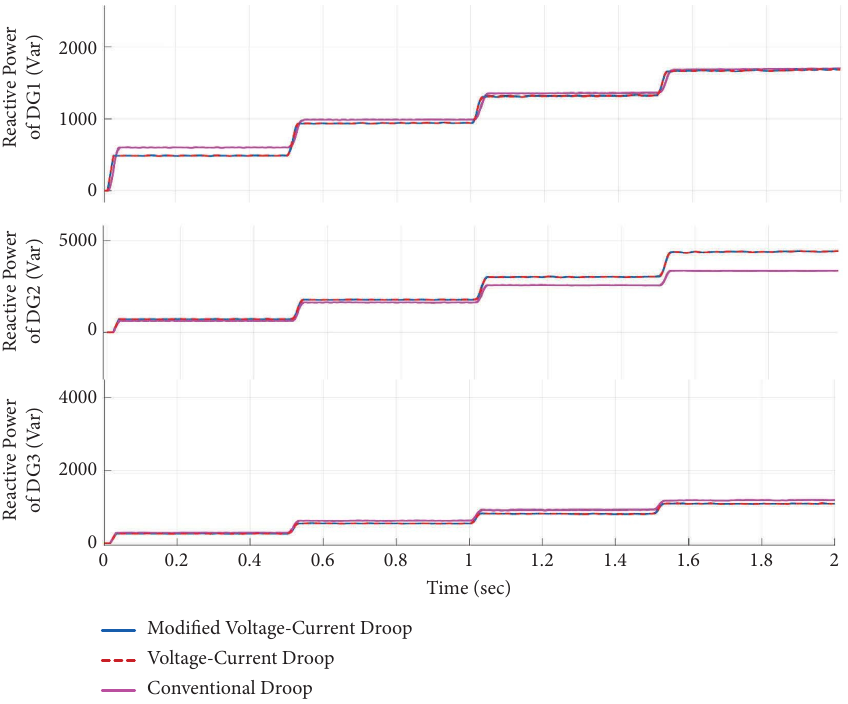
Figure 12: Reactive power injection of 5 bus test system.